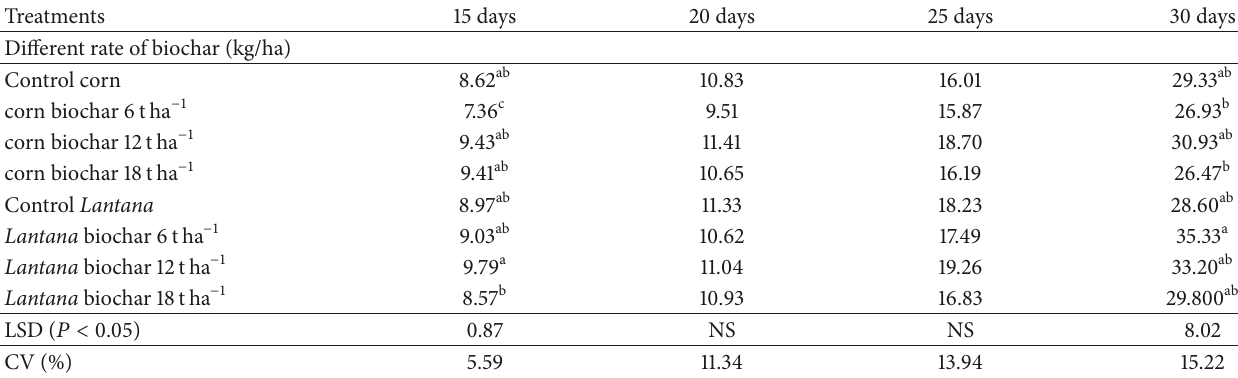
Table 3: Mean fifteen days, twenty days, twenty-five days, and thirty days of pea as influenced by different rate of biochar at Bule. Treatments